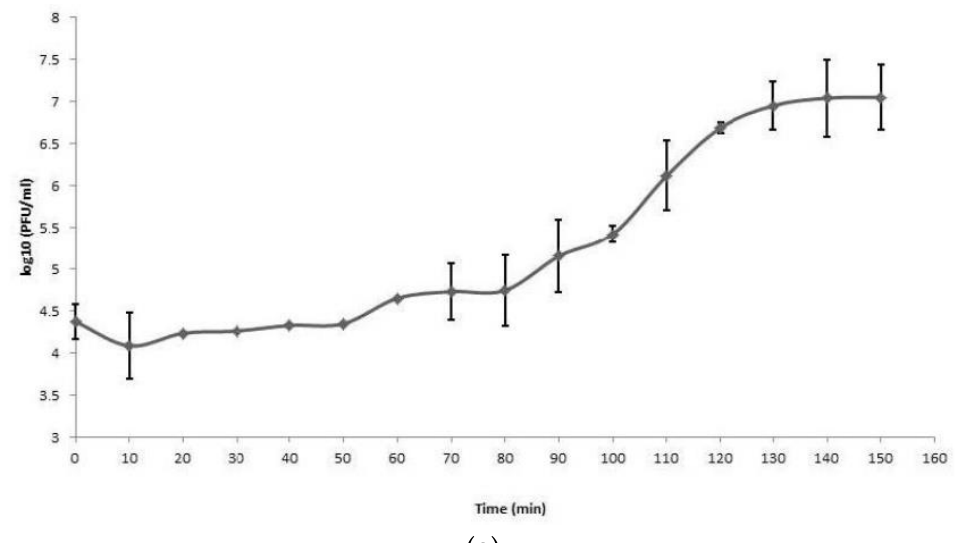
Figure 4. Adsorption rates of phages on K. pneumoniae Ni9. Bars indicate the percentage of adsorbed phages at different time points. Each bar represents the mean of three independent measurements. ( a ) LASTA; ( b ) SJM3. The replication cycle curve was determined by a one-step growth test. The latent period of both LASTA and SJM3 is 80 min, and their burst sizes (average number of phage particles produced by one infected cell) are 187 ± 37 and 155 ± 34 plaque-forming units per infected cell, respectively. The duration of the rise period—during which phage virions are released from lysed cells—is 60 min for LASTA and 50 min for SJM3, and the total replication cycle lasts 140 and 130 min, respectively (Figure 5).